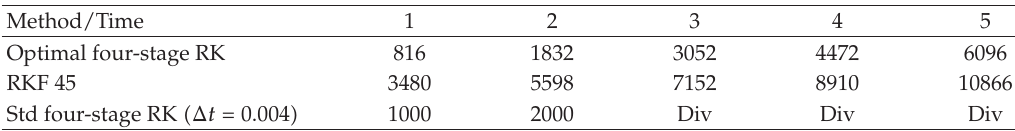
Table 3: Comparison for number of iterations among the optimal four-stage RK, RKF 45, and standard four-stage RK. The optimal four-stage RK method is counted four times for the function evaluation per iteration while the RKF 45 is six times per iteration.